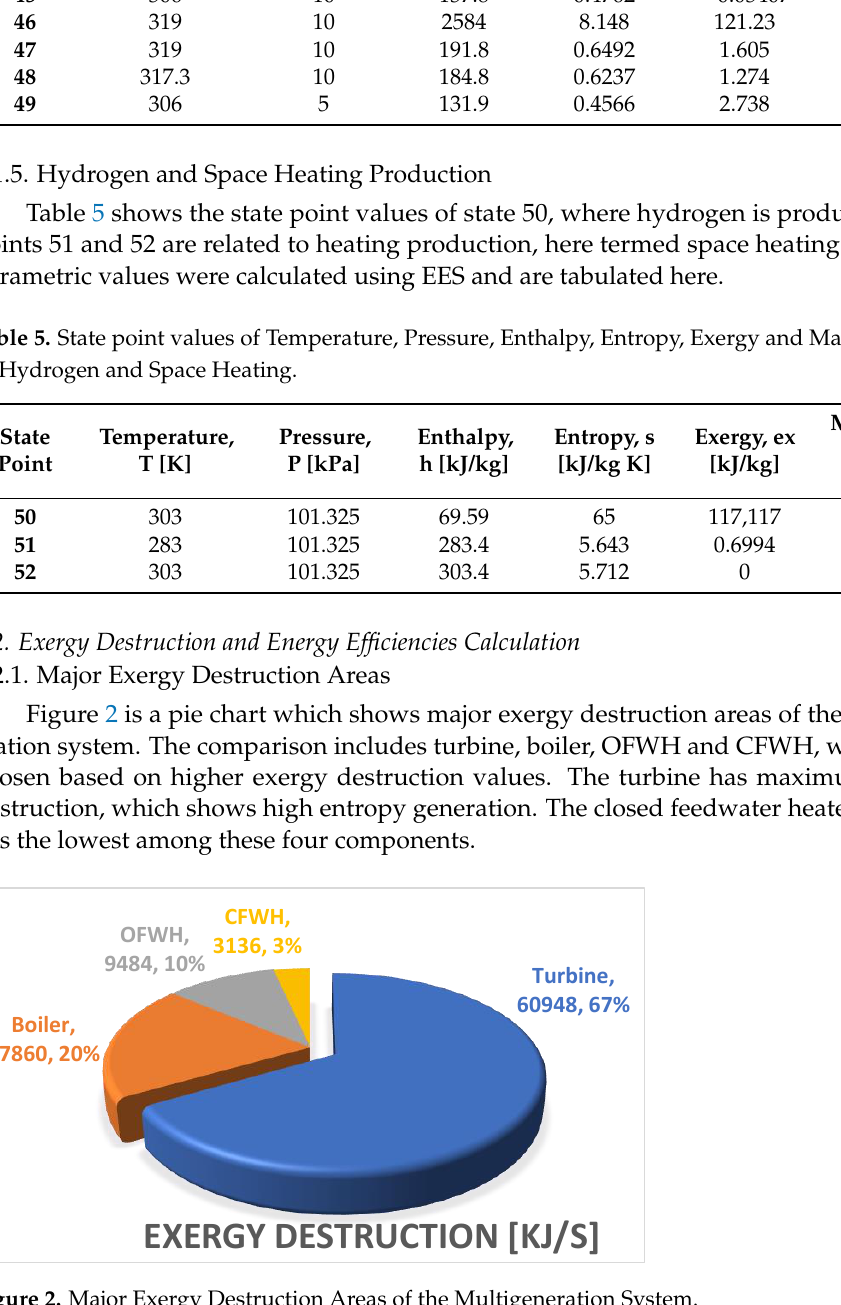
Figure 2. Major Exergy Destruction Areas of the Multigeneration System .